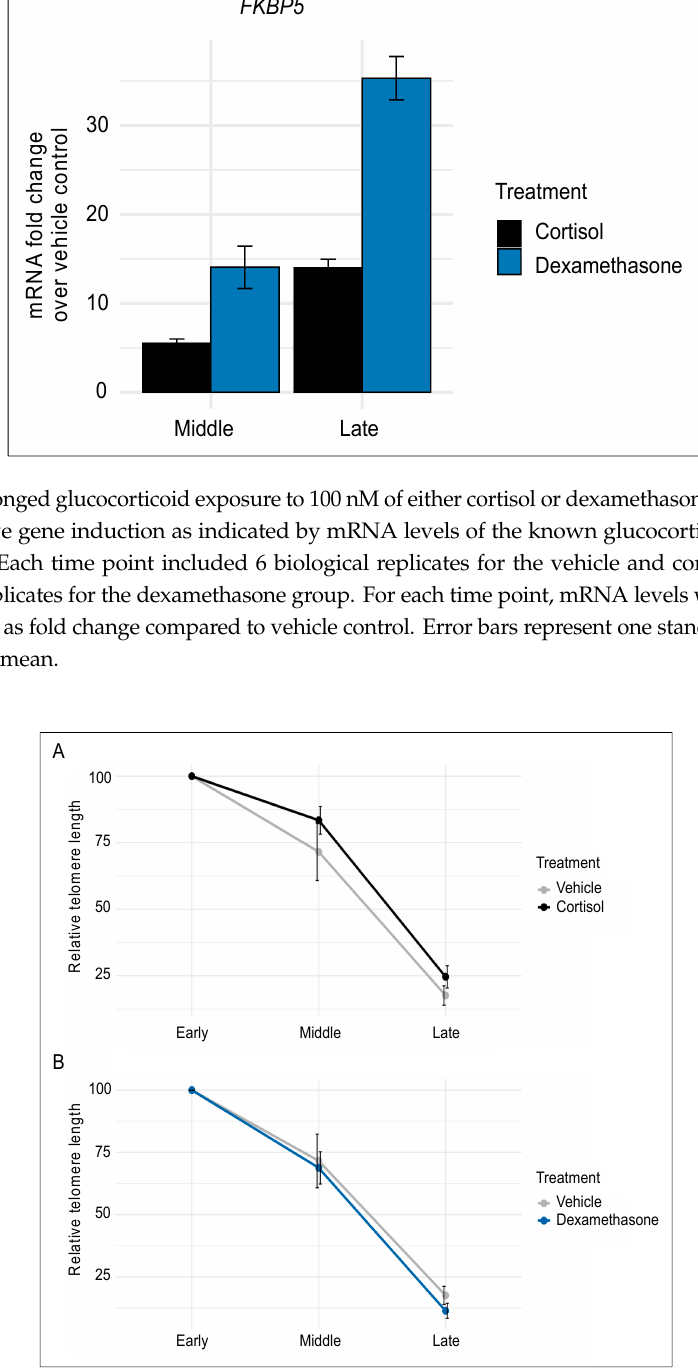
Figure 2. Prolonged exposure to 100 nM of either cortisol ( A ) or dexamethasone ( B ) does not influence the rate of telomere shortening observed during passaging of human fibroblasts. Telomere length was determined at early, middle, and late passage (0, 24, and 51 days of treatment, respectively). Each time point included 6 biological replicates for the vehicle and cortisol group and 5 biological replicates for the dexamethasone group. Relative telomere lengths were normalized and are shown as percent of the early passage cells. Error bars represent one standard error above and below the mean.